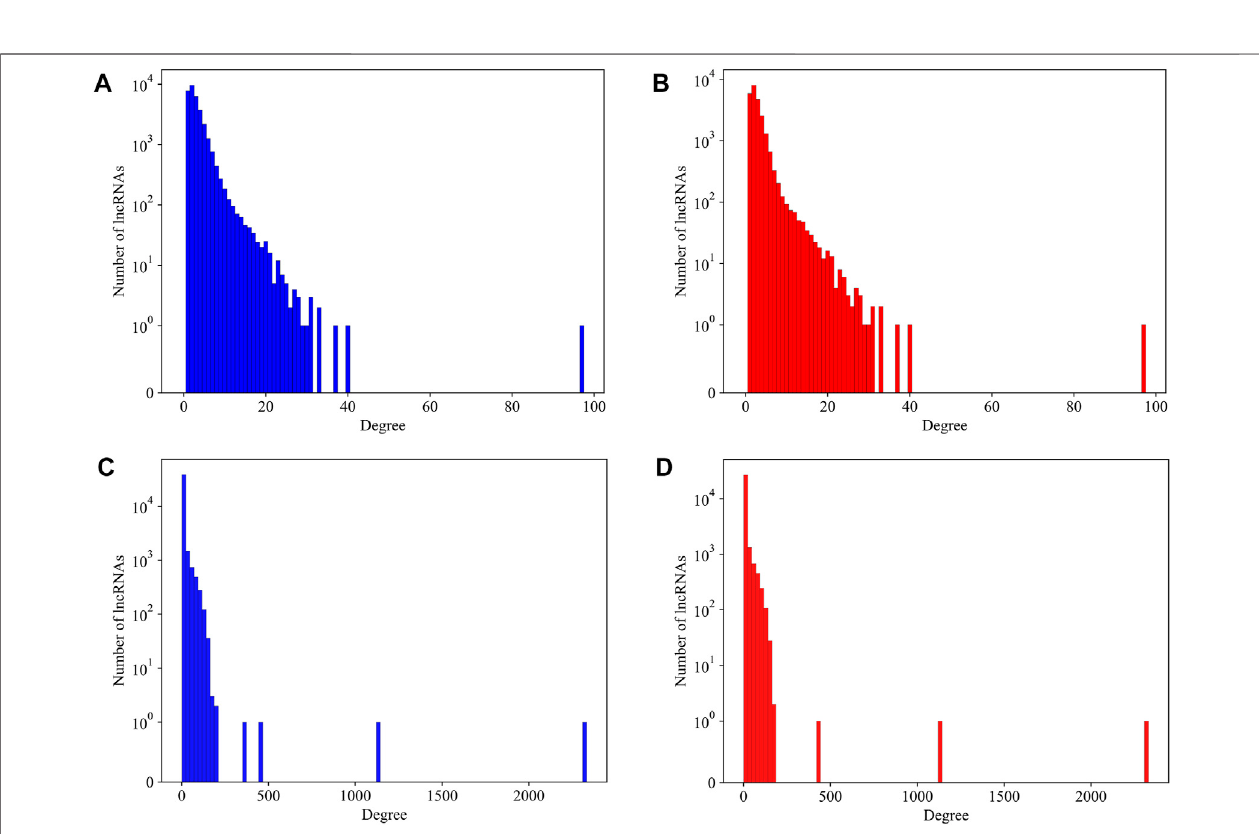
FIGURE 4 | The degree distribution of lncRNAs in mouse network and human network with and without over-length lncRNAs. (A) The degree distribution of lncRNAs in mouse network with over-length lncRNAs; (B) The degree distribution of lncRNAs in mouse network without over-length lncRNAs; (C) The degree distribution of lncRNAs in human network with over-length lncRNAs; (D) The degree distribution of lncRNAs in human network without over-length lncRNAs.